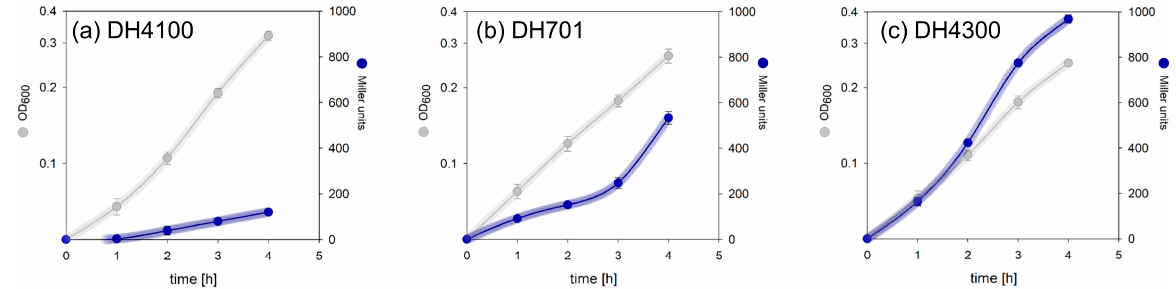
Figure 1. Impaired formate homeostasis and growth rate of focA mutants . Shown are the optical densities (gray lines) and formate-reporter enzyme activities (blue lines), representing changes in intracellular formate levels, for the indicated strains during the first 4 h of fermentative growth. Strains: ( a ), DH4100, parental; ( b ), DH701 ( focA ); and ( c ), DH4300, synthesizes FocA T91A .